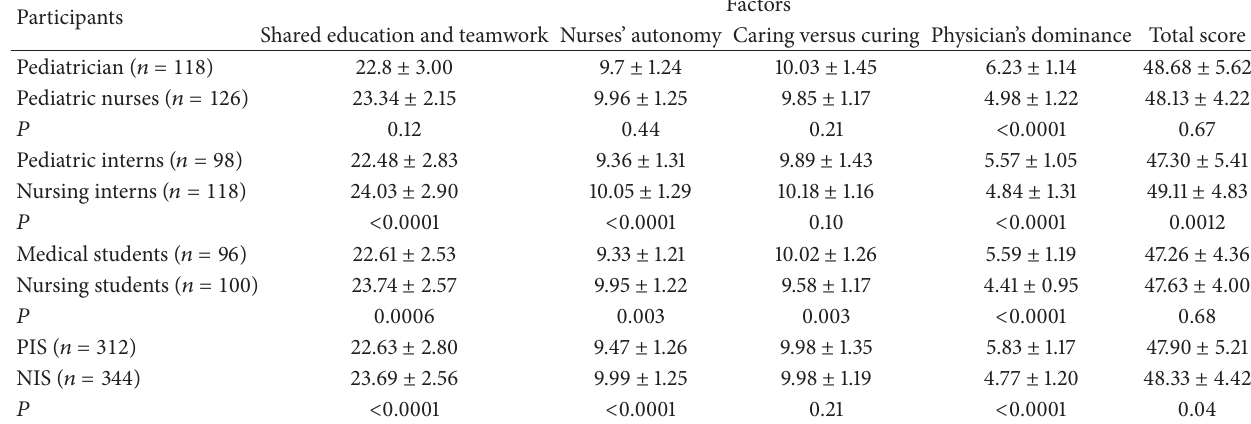
Table2:ComparisonsofparticipantsontotalscoresandfourfactorsoftheJeffersonScaleofAttitudestowardPhysician-NurseCollaboration.